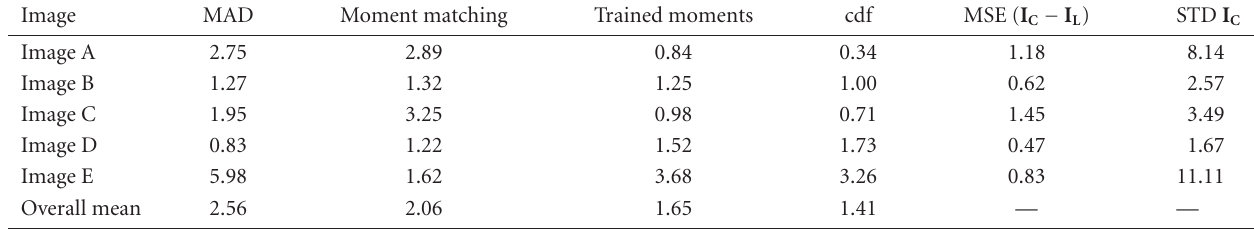
Table 2: Mean squared errors for noise standard deviation estimates computed over 6 noise levels (columns 2–5); mean squared error between image component and synthetically generated image with optimal Laplacian distribution (column 6); and standard deviation of the image component (column